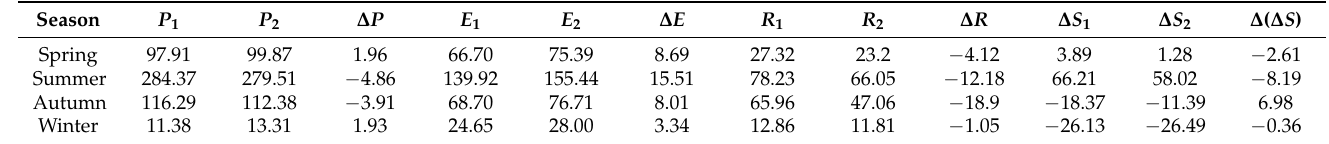
Table 4. The eigenvalues of different climatic and hydrological